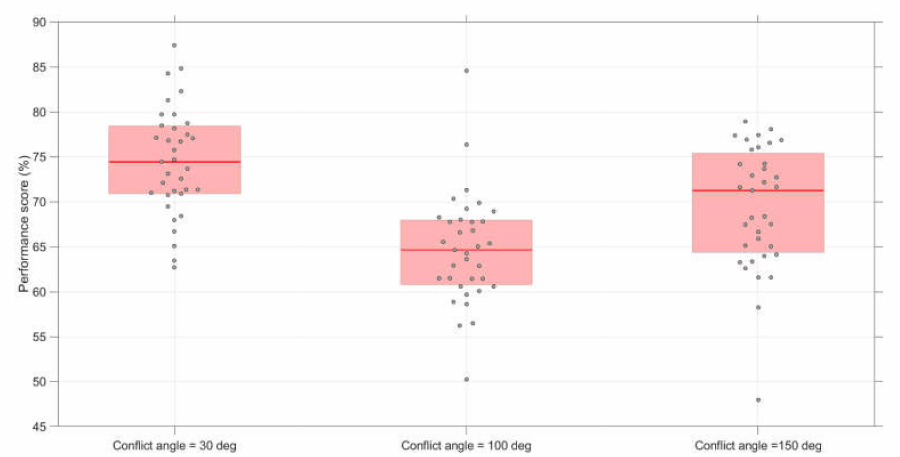
Figure 5. Boxplots of the performance scores per conflict angle. The score for each participant represents the average of 12 scenarios (conflict scenarios and non-conflict scenarios